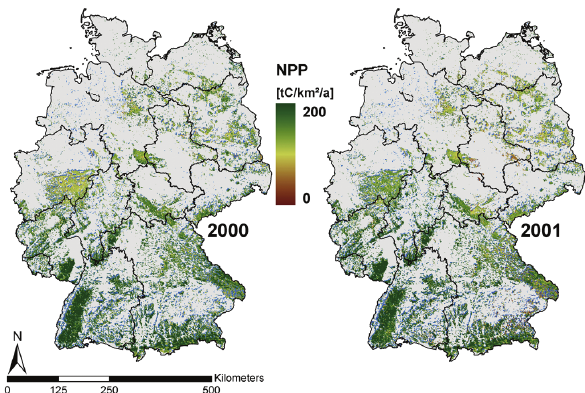
Table 4. Per-species percentage of timber stock biomass (without bark) to total above-ground biomass ( P ) from Kramer and Kr¨uger (1981), max ε from Dieter and Englert (2001), and min ε from Kaltschmidt and Hartmann (2009). / = no value. ε (tm − 3 ) P per age class Species min max II Spruce Pine Beech 0.56